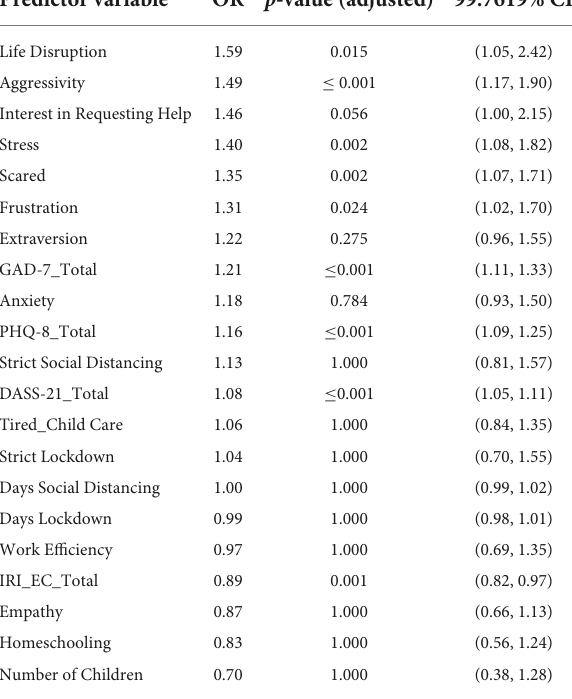
TABLE 4 (Time 3): Predictors of verbal fights between partners in the unregularized regression model. Predictor variable OR p -value (adjusted) 99.7619%